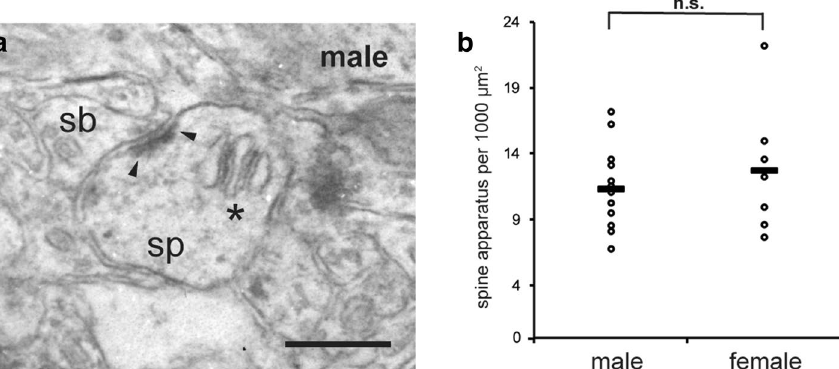
Figure 2. The number of spine apparatuses is similar in the hippocampus of male and female wild-type (WT) mice in situ . ( a ) Representative example of a spine apparatus (SA, asterisks) in the neck of a dendritic spine (sp) in stratum radiatum of CA1 region of the hippocampus of male WT mice; postsynaptic density (arrow heads), synaptic bouton (sb). Scale bar represents 250 nm. ( b ) Counts of spine apparatuses revealed no difference in spine apparatus number in male and female WT (p = 0.484; mixed model analysis; n = 4 male and n = 3 female animals). In the scatterplot “ - ” indicates the